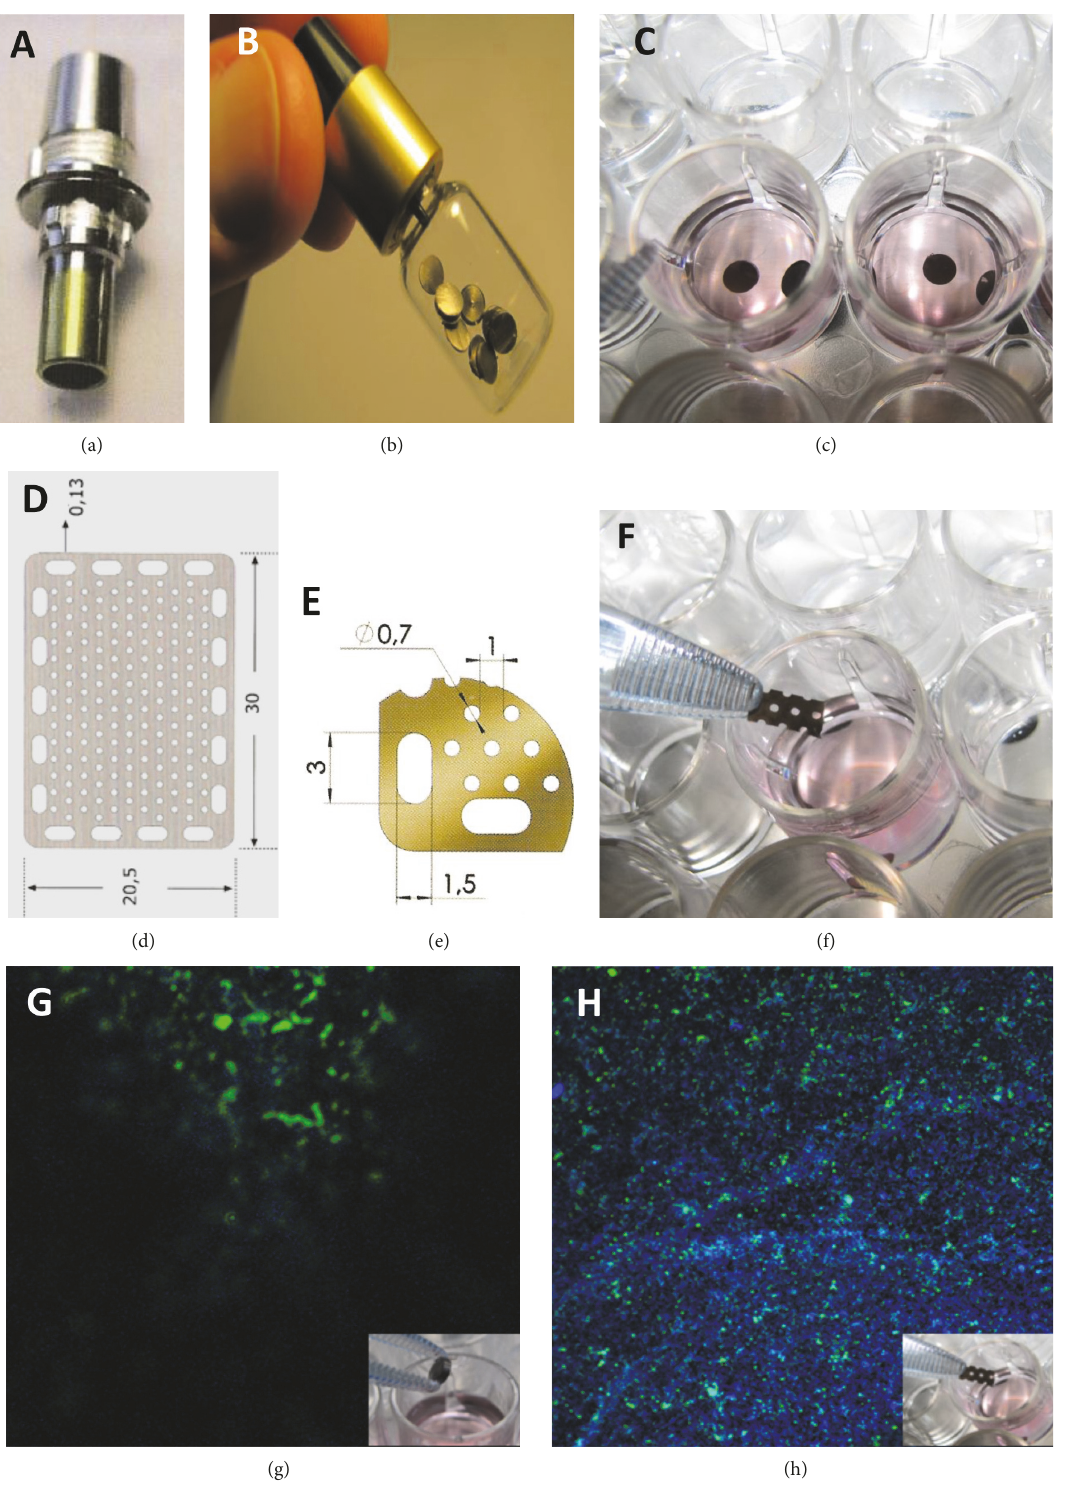
Figure 4: Titanium sca ff olds: Titanium type 1. (a) The original endosseous implants before cutting, (b) titanium after cutting and sterilization, (c) titanium type 1 in a 24-well plate before osteogenic di ff erentiation experiments. Titanium type 2. (d) The original titanium grill before cutting. (e) The dimensions of the di ff erent perforations. (f) Titanium type 2 in a 24-well plate before osteogenic di ff erentiation experiments. (g) Titanium type 1 immuno fl uorescence images by confocal microscopy, the low resolution of the osteocalcin and nuclei signals are evident (green and blue, resp.). (h) Titanium type 2 immuno fl uorescence images by confocal microscopy, it is evident how the more fl at surface of this sca ff old is better suited for confocal microscopy